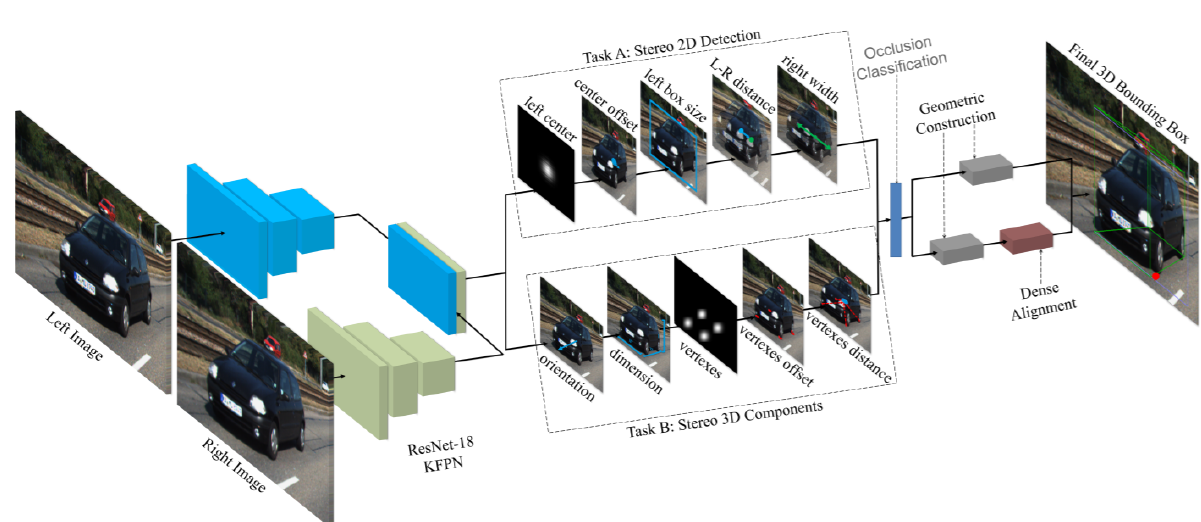
Figure 10. Network architecture of Stereo CenterNet [60] with 10 outputs and sub-branches for two tasks and the estimated 3D BBoxes.